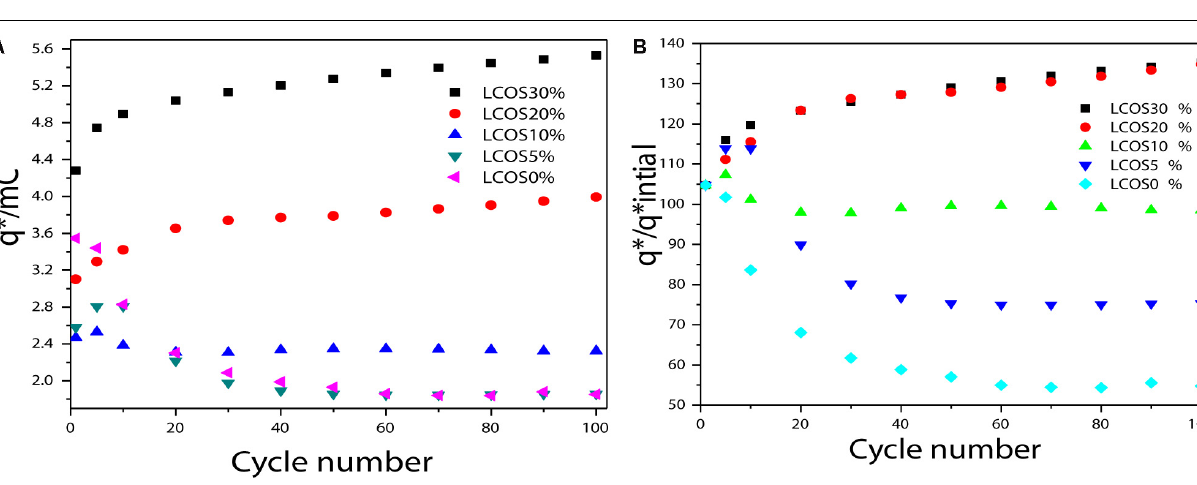
Frontiers in Materials |